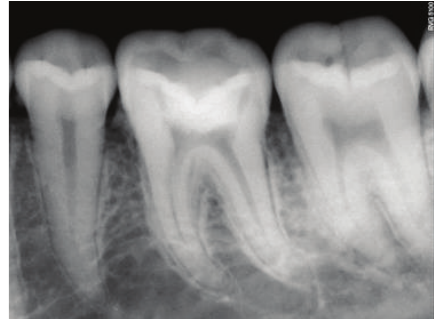
Figure 12: 22-month followup RVG 46.